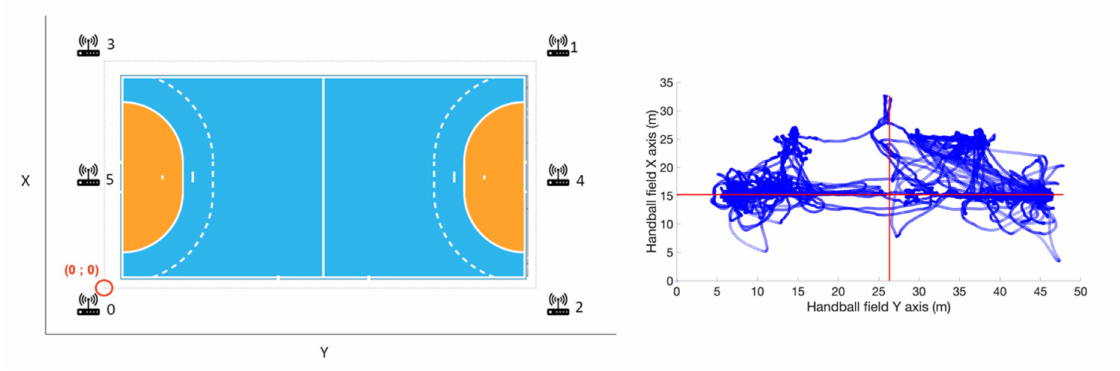
Figure 1. The six antennas configuration, positioned around the handball field with the (0;0) coordi- nates on the lower left corner ( left panel). Corresponding positions reported on the field for the two GK (in blue, right panel), and the computed center of the field, that becomes the (0;0) coordinates system (crossing red